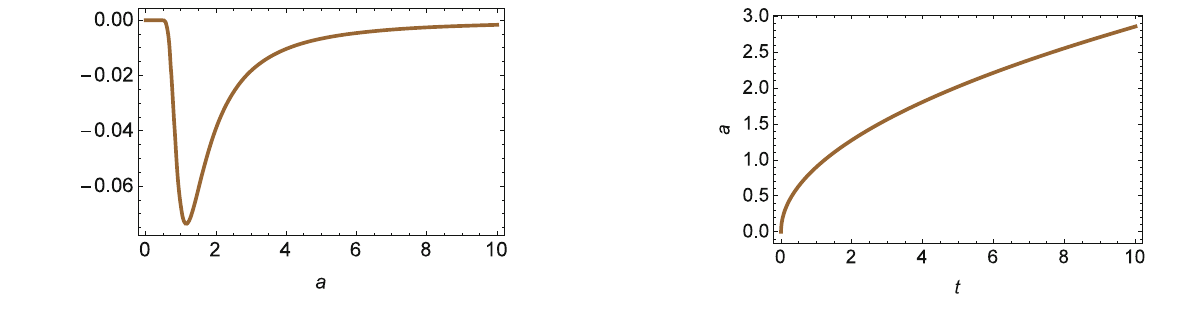
Fig. 3 The function of effective potential V eff ( a ) vs. scale factor a Fig. 4 The function of scale factor a ( t ) vs. cosmic time t then, a ( t ) accelerates to the left of a c and decelerates to the right of a c . This acceleration is due to nonlinear electrody- namics which behaves similarly to dark